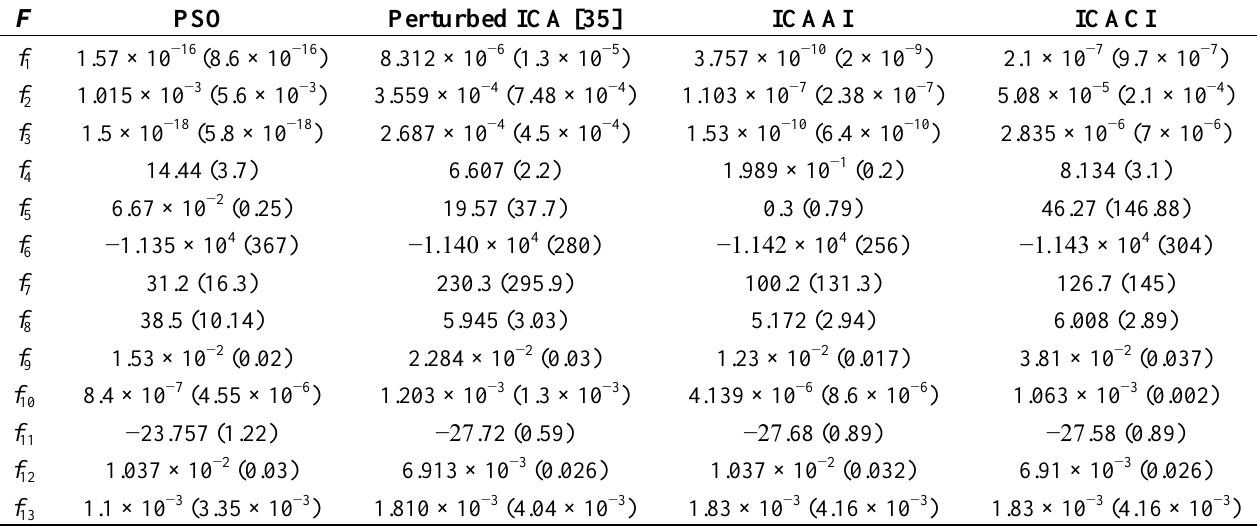
Table 2. Average and standard deviation of the best objective values over 30 runs after 1000 generations. The standard deviation is shown in